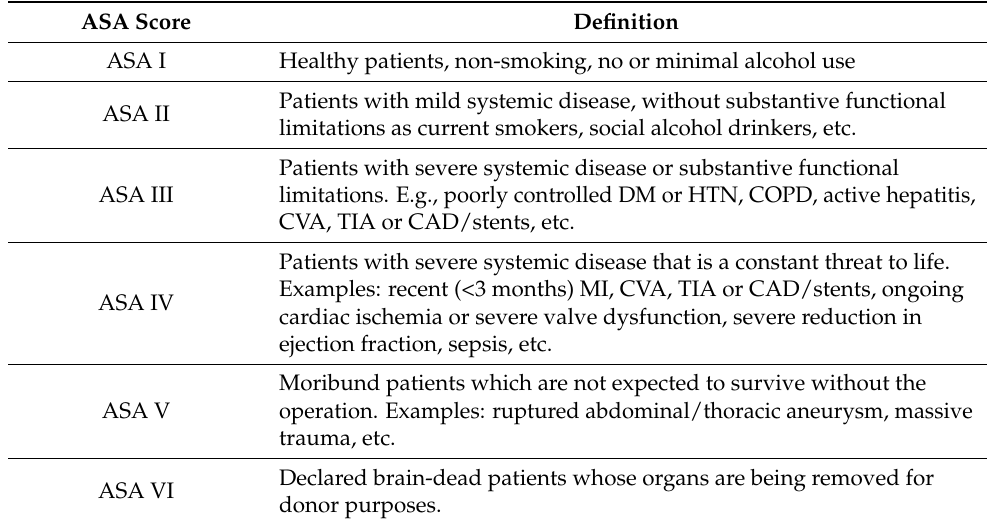
Table 1. ASA Physical Status Classification